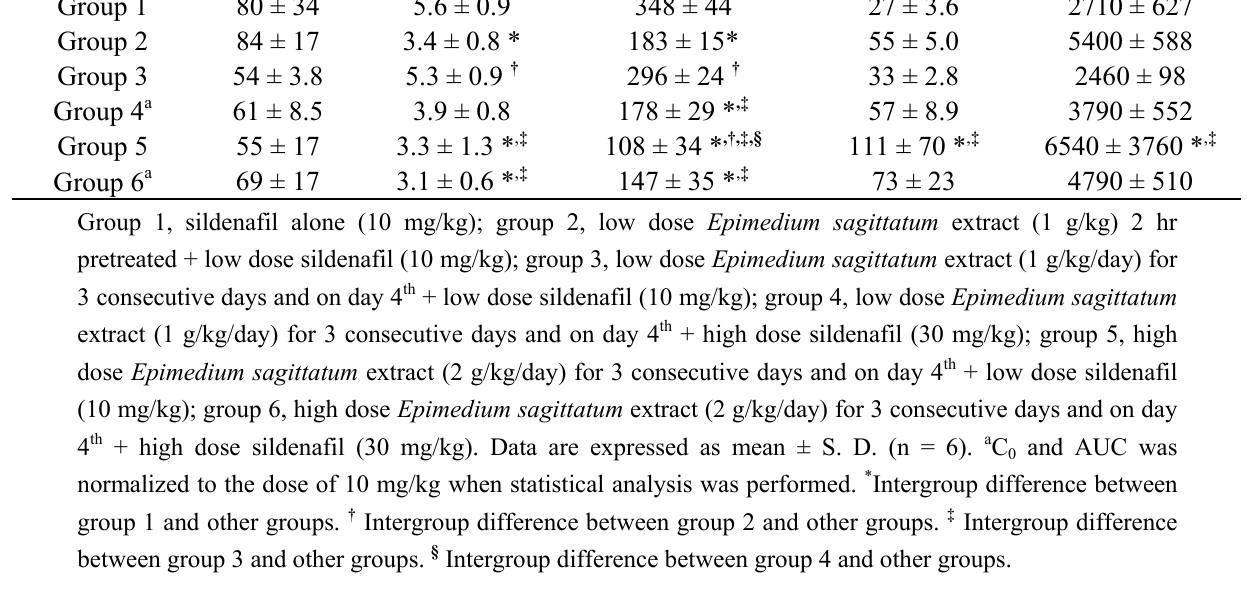
Table 5. Pharmacokinetic parameters of dose-normalized sildenafil in various groups.